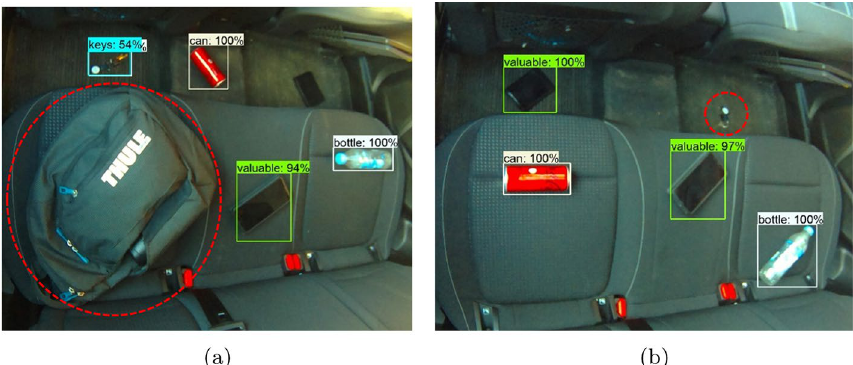
Fig. 28 Two examples of predicted images with a high quantity of items scattered across the seating area. Red dotted circles correspond to instances of undetected items ( a bag and b